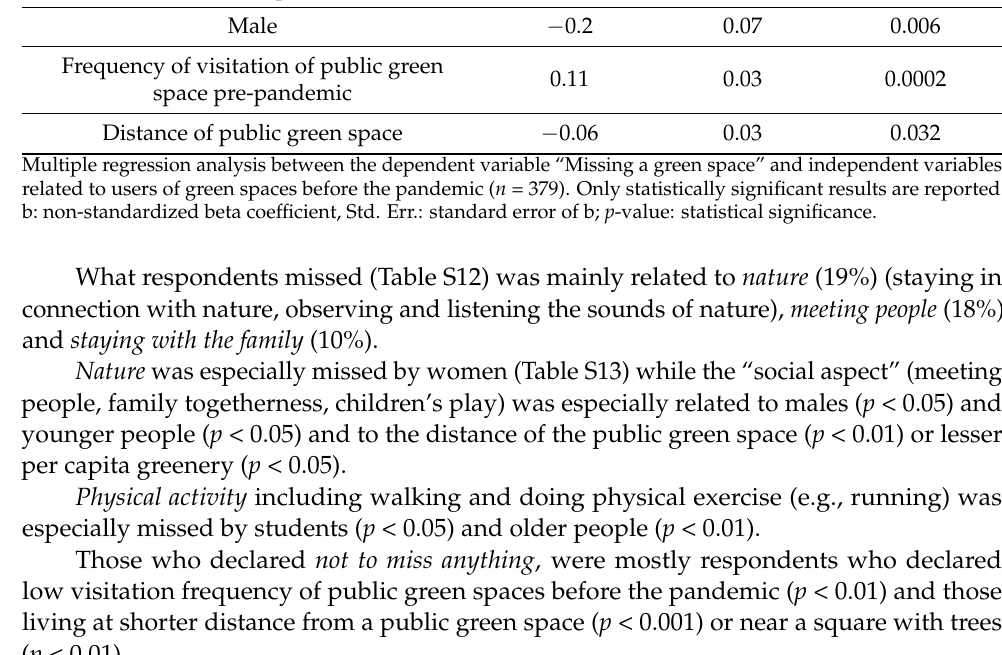
Table 5. Relationship between “Missing of a green space” and independent variables related to private (resulting not significant) and public green spaces. b Std. Err. p -Value Intercept 3.67 0.13 0 Male − 0.2 0.07